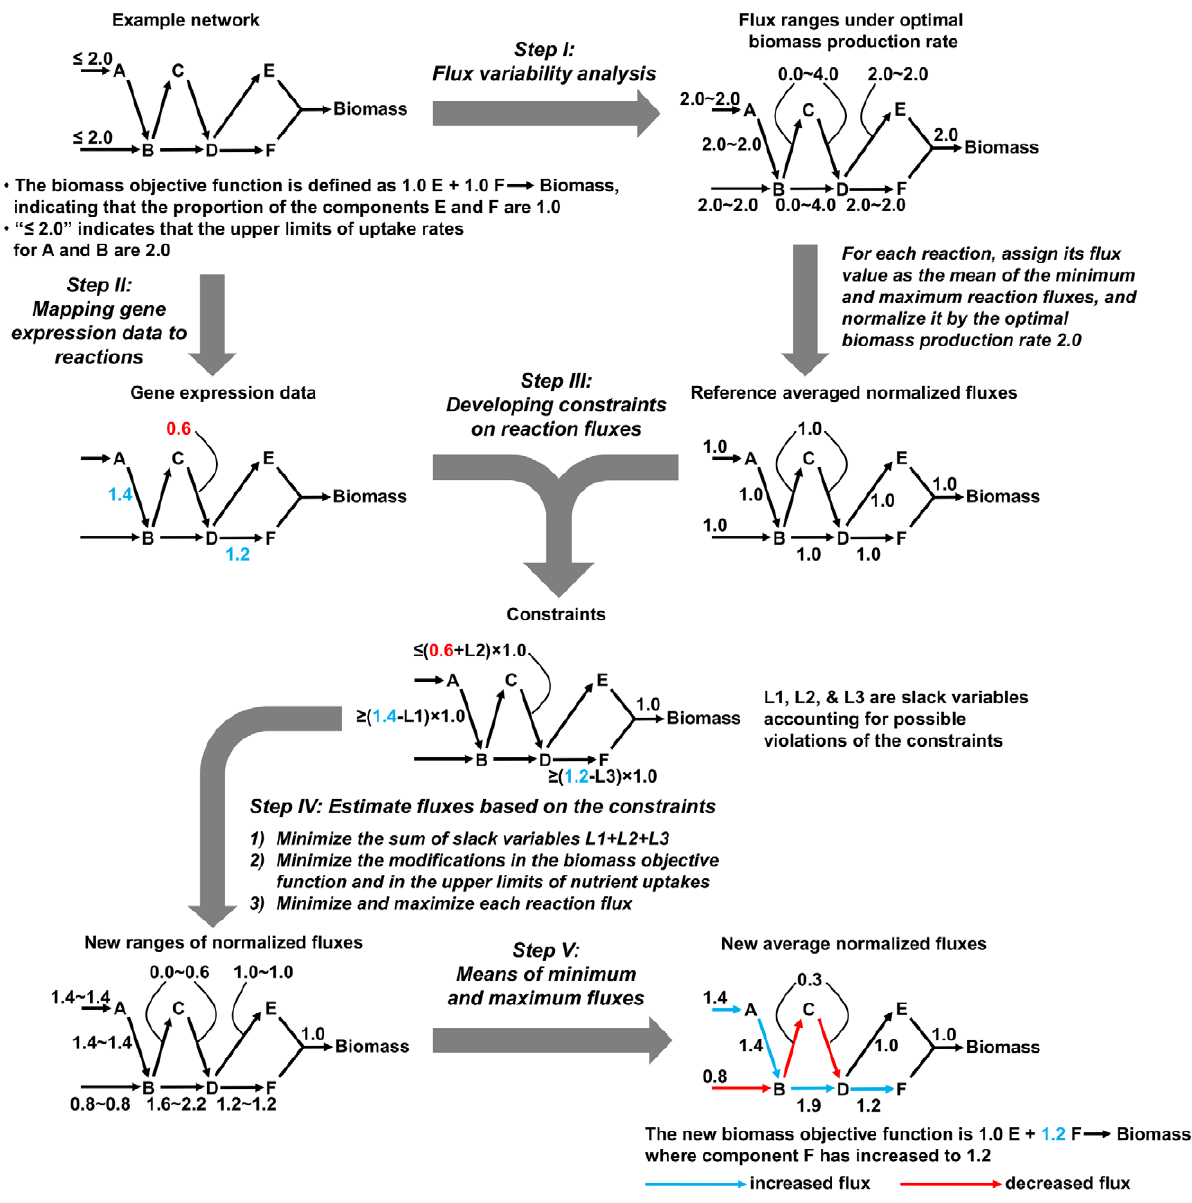
Figure 1. Schematic description of integrating a small example metabolic network with gene expression data. Construction of the altered metabolic state used gene expression data to constrain and alter the reference fluxes obtained from a metabolic network compatible with the reference condition. The example network contained six metabolites (A–F), two uptake reactions, six enzymatic reactions, and one biomass reaction. In the reference condition, the biomass function contained equal amounts of metabolites E and F, set to 1.0 millimoles per gram dry weight of the organism (mmol/gDW), and the uptake rates for the metabolites A and B were each assigned an upper limit of 2.0 mmol/(h ? gDW). In Step I, we obtained the minimum and maximum fluxes under the optimal biomass production rate via flux variability analysis and calculated the average normalized flux for the reference metabolic network. In Step II, the gene expression ratios were mapped to their corresponding reactions. In Step III, we initially set constraints for reactions that were associated with altered gene expression values. These constraints were based on the normalized reference network with the biomass production rate set to one and resulted in increased normalized fluxes through reactions related to up-regulated genes (reactions A R B and D R F) and decreased fluxes related to down-regulated genes (reaction C R D). Because biological activities other than gene transcription can influence reaction fluxes, we introduced a set of non-negative slack variables (L1, L2, and L3) to account for possible violations of the constraints. In Step IV, we further performed a number of optimizations subject to the constraints from the previous step and obtained a new minimum and maximum normalized flux for each reaction. We first minimized the overall violation of the developed constraints in the form of the sum of the slack variables (highest priority). We then minimized the modifications in the biomass objective function and those in the upper limits of metabolite uptakes (medium priority), and, last, we minimized and maximized each reaction flux (lowest priority). Finally, in Step V, we constructed the new metabolic state by calculating the new average normalized flux for each reaction as the mean of its new minimum and maximum fluxes. This metabolic state was representative of the new condition and in this case was associated with altered uptake rates, pathway preferences, and an altered biomass